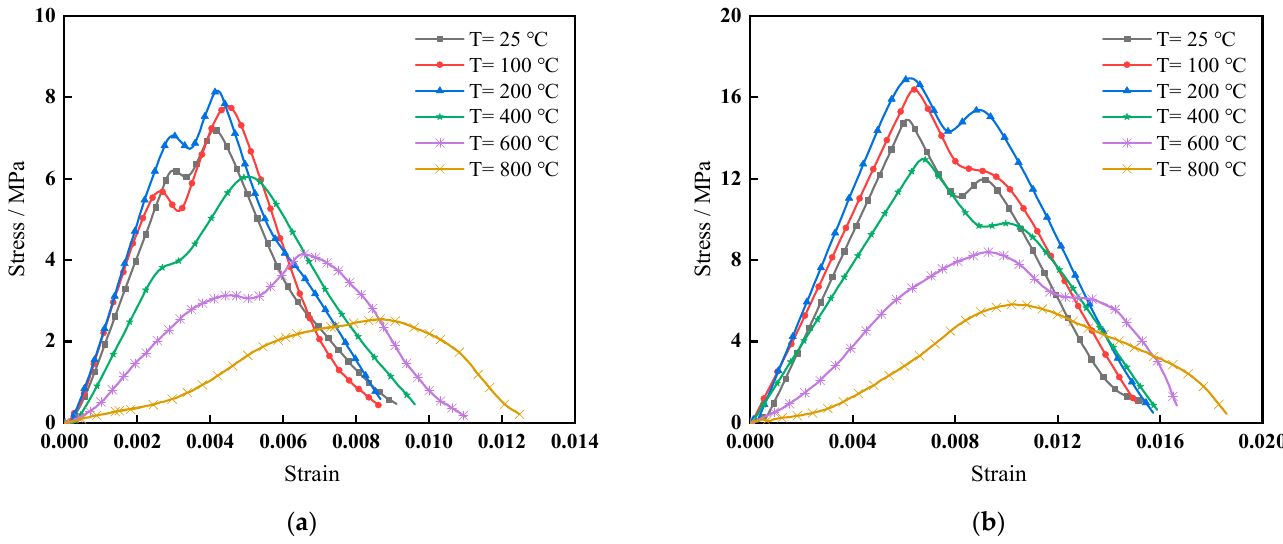
Figure 10. Splitting tensile stress–strain curve of concrete under different temperature groups. ( a ) PC; ( b ) S1PP0.2. ( b ) S1PP0.2.